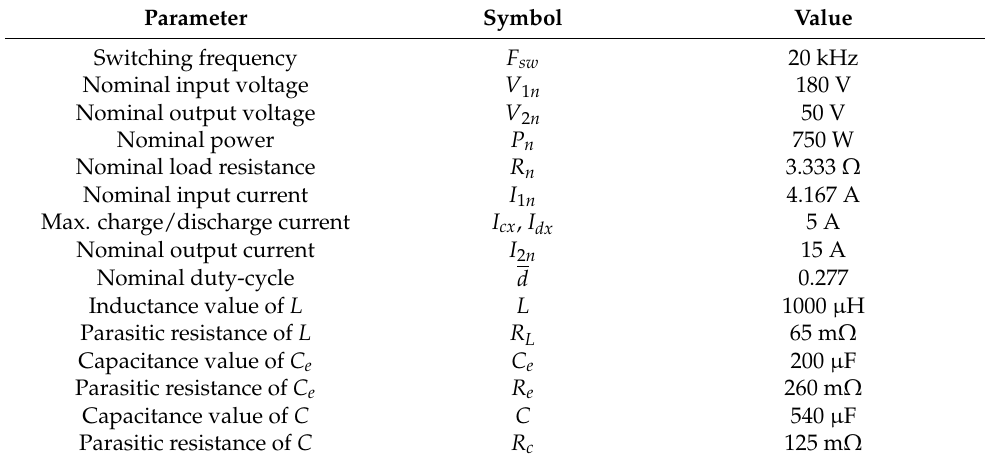
Table 2. Main parameters of the Split-pi converter. Parameter Symbol